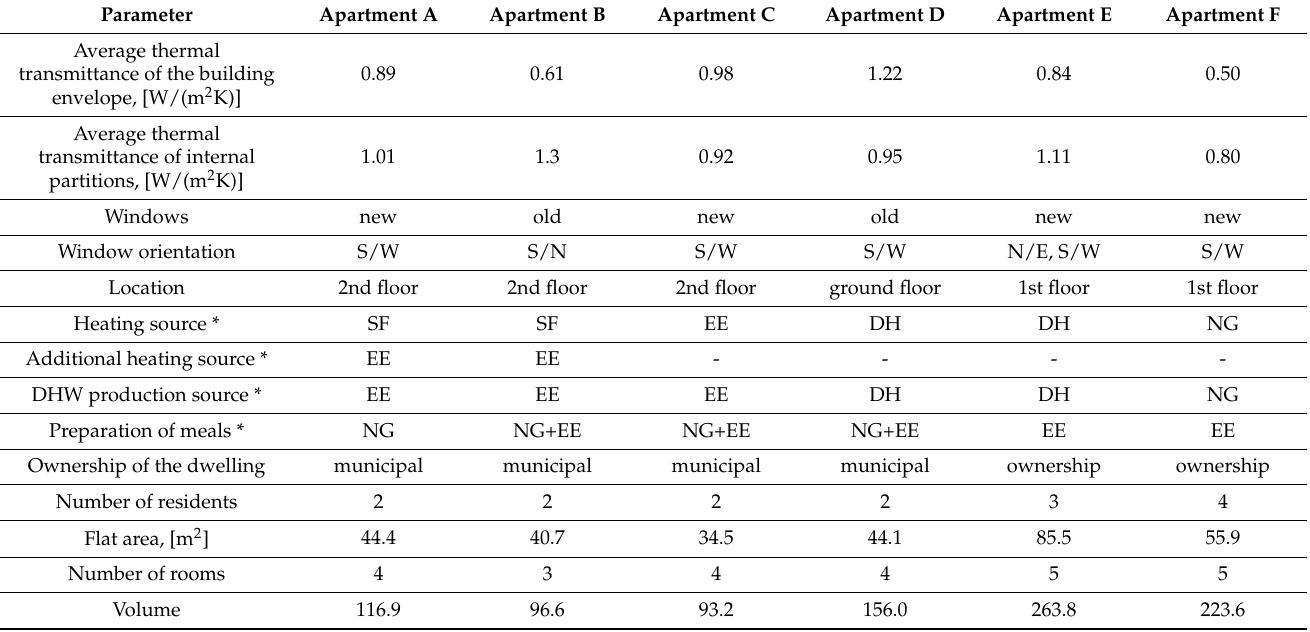
Table 1. Basic information about the